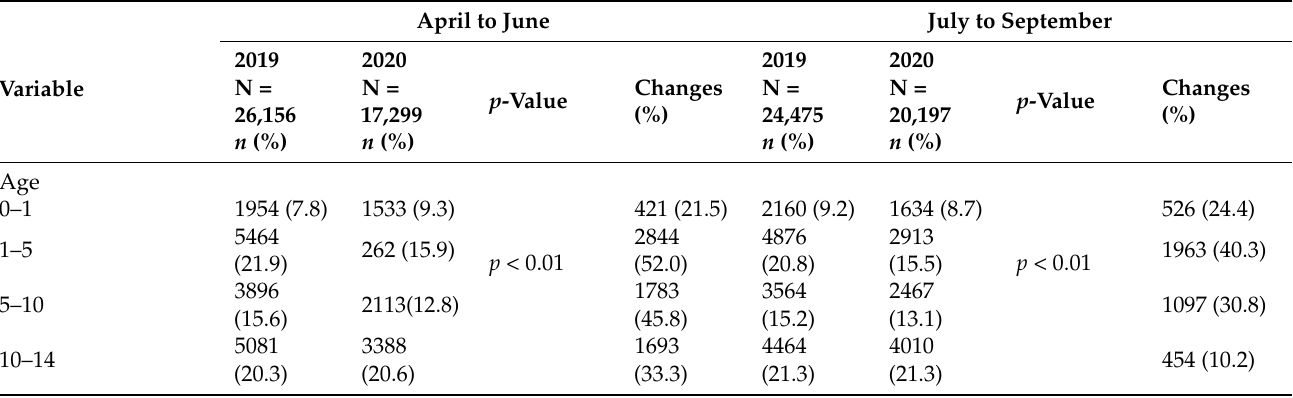
Table 2. Changes in Inpatient Hospital Visits during COVID-19 pandemic by the patient and hospital